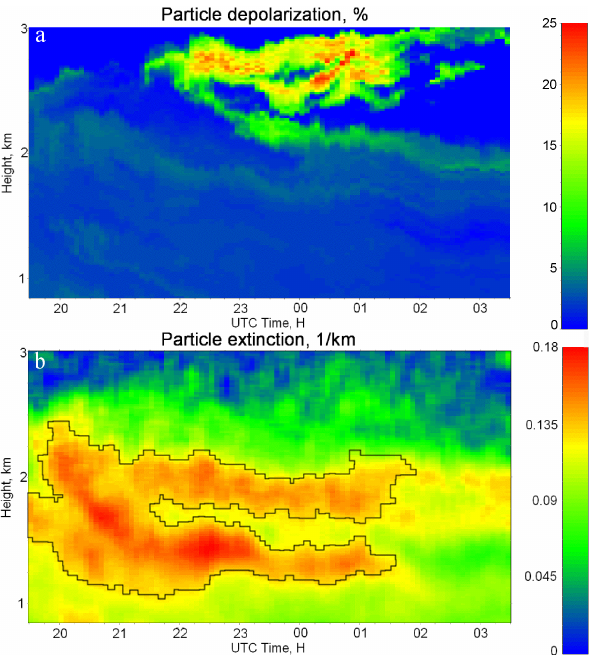
Fig. 6. Particle (a) depolarization ratio and (b) extinction at 355nm measured near Istanbul on 20 May 2010. Vertical resolution is 30m for depolarization and 150m for extinction.